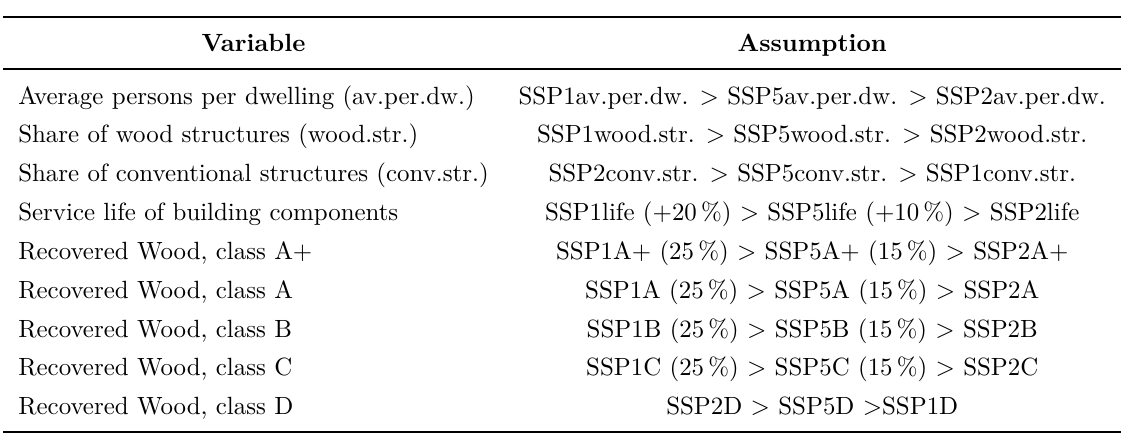
Table 3. Variables included in the model and the associated assumptions of the MFA